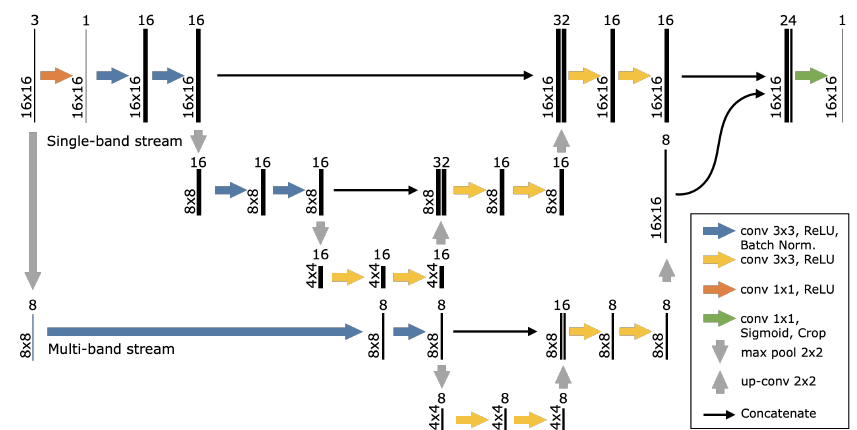
Figure 5. Schematic of NU-Net architecture proposed in this study. NU-Net is a modified lightweight version of RS-Net with multi-stream architecture in order to suppress the network from optimizing in color features.